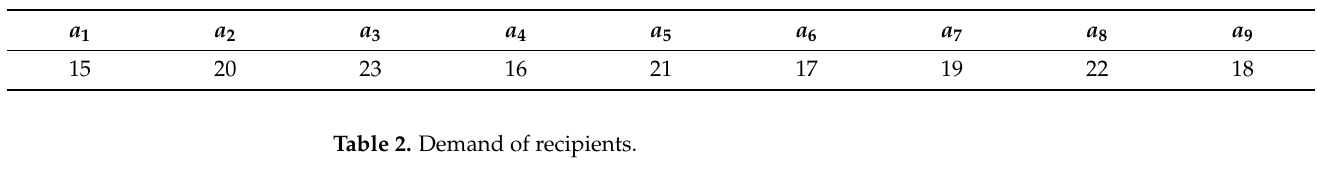
Table 1. Completion potential of suppliers.